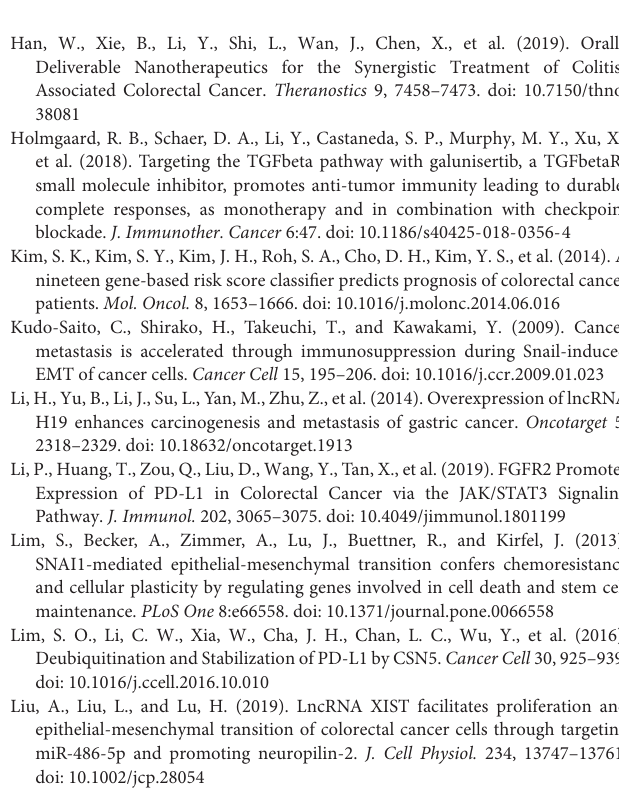
Supplementary Figure 1 | Expression of ISM1 in gastrointestinal cancers. ESCA, esophageal carcinoma; STAD, stomach adenocarcinoma; LIHC, liver hepatocellular carcinoma; CHOL, cholangiocarcinoma; PAAD, pancreatic adenocarcinoma; COAD, colon adenocarcinoma; READ, rectum adenocarcinoma. ∗ P < 0.05. Supplementary Figure 2 | Subgroup OS analysis of ISM1 expression in CRC. Patients were stratified based on age (A) , sex (B) , T status (C) , lymph node status (D) , stage (E) , and malignancy history (F) . P < 0.05 is statistically significant. Supplementary Figure 3 | Activity score of multiple cancer-related pathways associated with ISM1 expression. (A–F) Epithelial mesenchymal transition, angiogenesis, the Hedgehog signaling pathway, the KRAS signaling pathway and hypoxia showed higher activity scores in CRC patients overexpressing ISM1. Supplementary Figure 4 | Activity score of multiple immune-related pathways associated with ISM1 expression. (A–F) TGF- β , inflammatory response, IL2/STAT5, TNF- α /NF- κ B, IFN- γ response, and the IL6/JAK/STAT3 signaling pathway showed higher activity scores in CRC patients overexpressing ISM1. Supplementary Figure 5 | Expression of ISM1 in microenvironment in patients treated with immunotherapy. (A) Differentially expressed analysis of ISM1 in three distinct immunological phenotypes, (B) SD/PD patients with immune-excluded tumors vs. CR/PR patients with inflamed tumors. Complete response (CR), partial response (PR), and progressive disease (PD). P < 0.05 is statistically significant. Supplementary Table 1 | Information for calculating EMT activity score across 22 cancers from